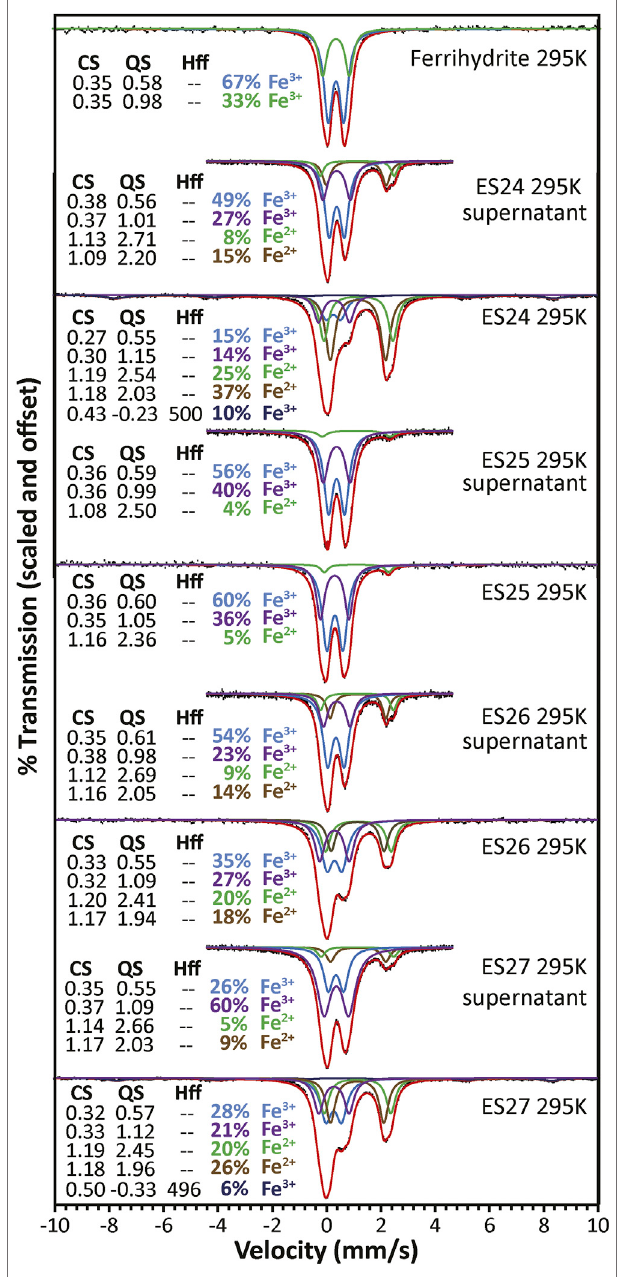
FIGURE7| MössbauerspectraofBloodFallssamplesES24-27prepared as both bulk and supernatant along with a Mössbauer spectrum of ferrihydrite. Fit parameters are listed on the plot. CS, center shift in mm/s; QS, quadrupole splitting in mm/s; Hff, hyper fi ne fi eld in kOe. Each doublet or sextet may represent a single iron environment or, more likely, a mixture of different iron environments across one or multiple minerals. The percentage listed for each distributionisthe%areainthatdoubletorsextetisonlythemol%inanindividual ironsiteif 1 )itisknownthatthedistributiononlyrepresentsironinonesiteand 2 ) if the value is corrected by the recoil free fraction for that site in that